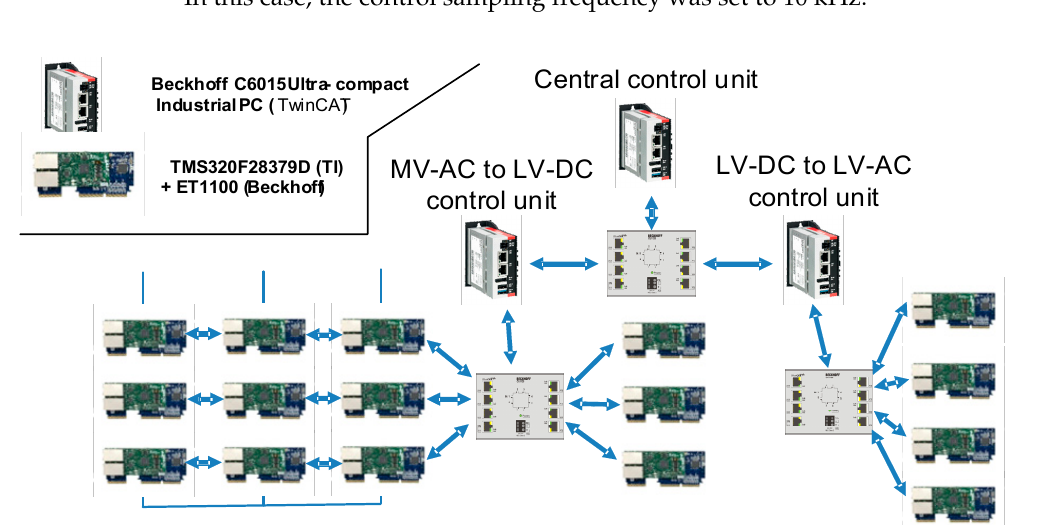
Figure 14. Design of EtherCAT communication structure for whole smart transformer.